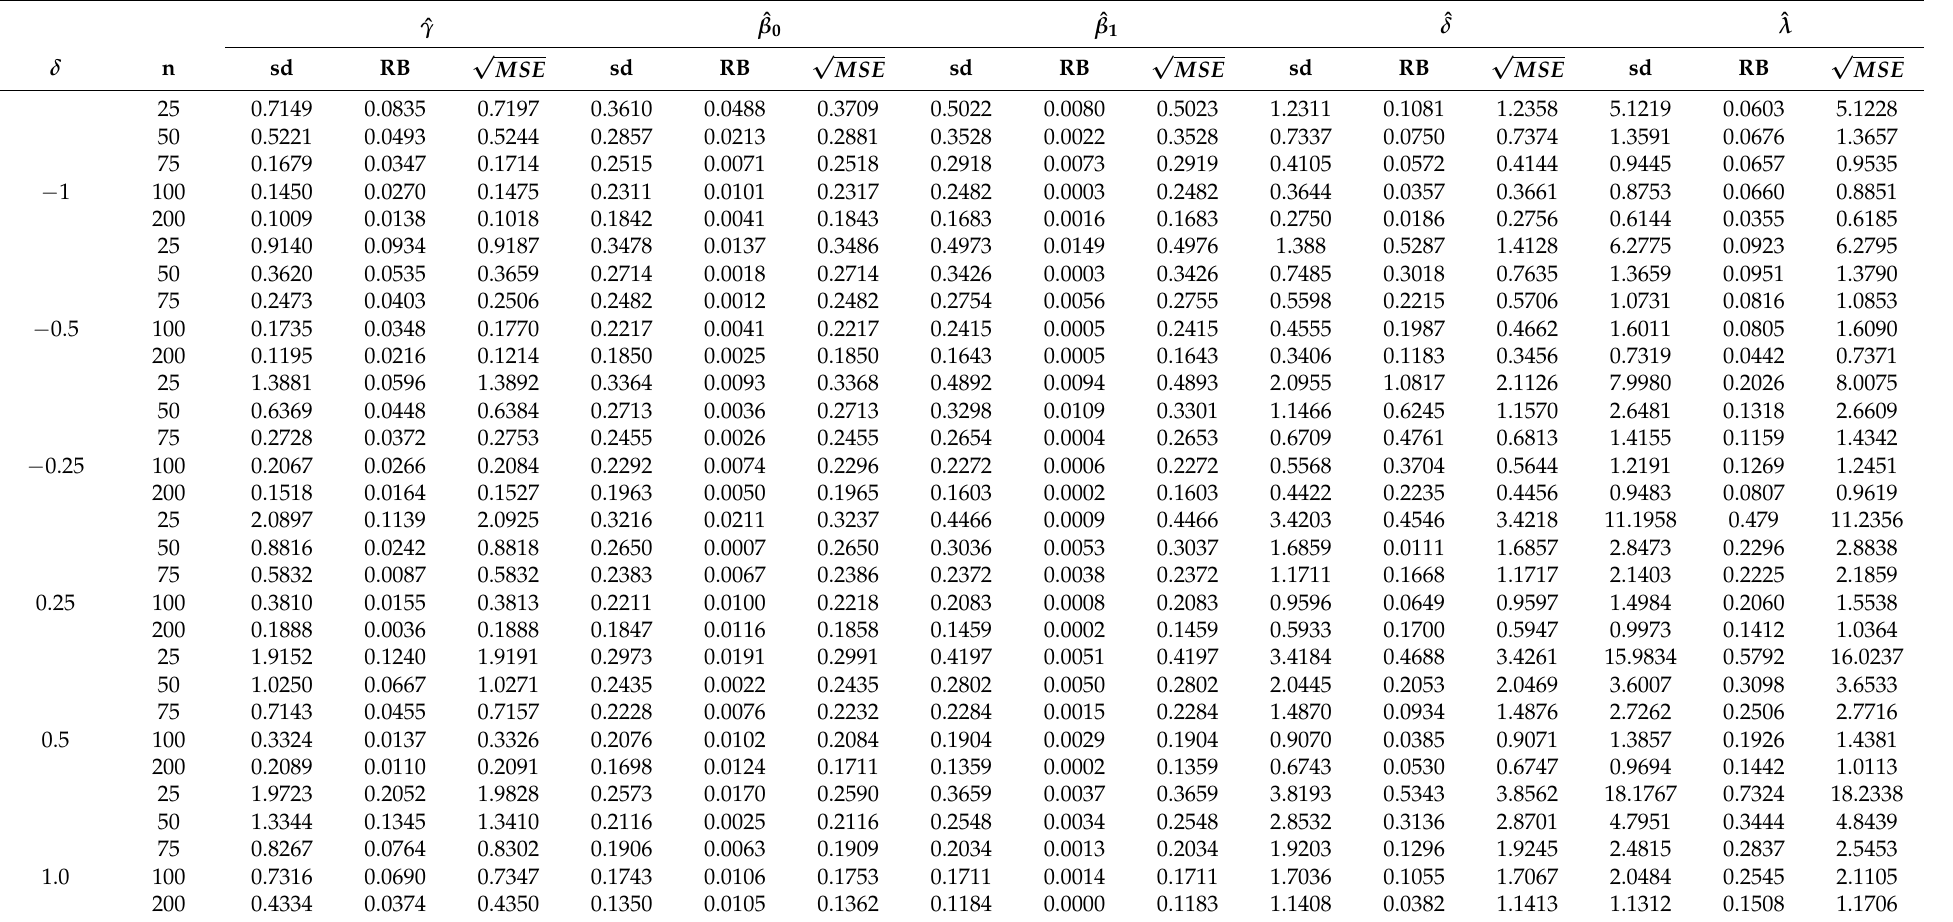
√ MSE for the FSHN ( 1,1.75,1.25, δ ,2 )